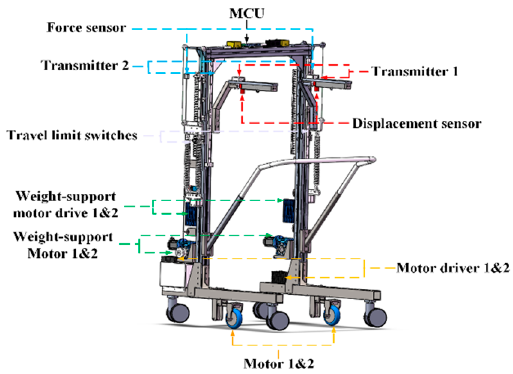
Figure 7. Hardware and sensing systems of the rehabilitation robots.